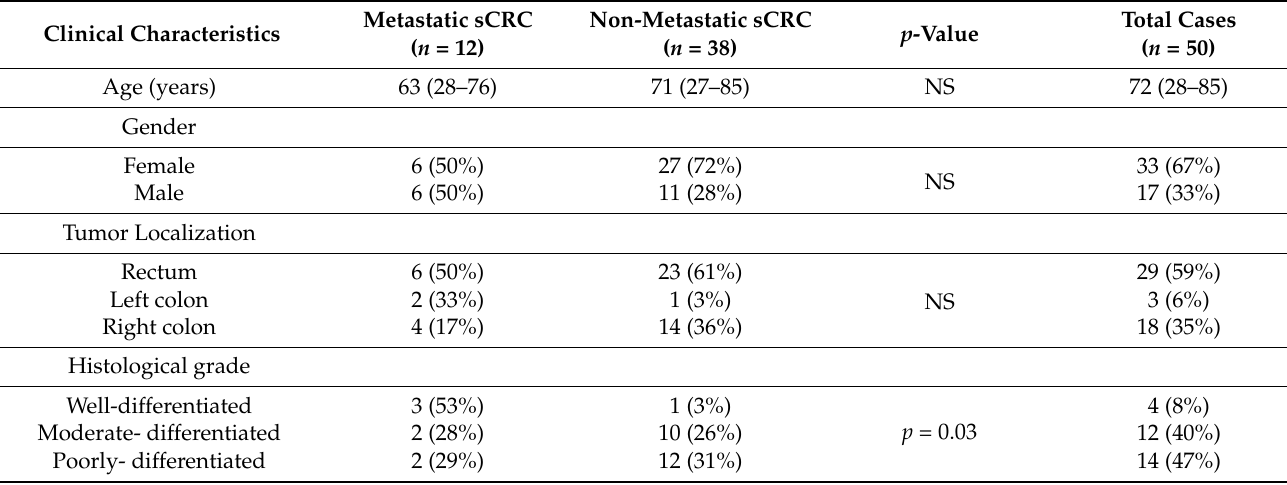
Table 1. Clinical and biological characteristics of non-metastatic ( n = 38) vs. metastatic ( n = 12) sporadic colorectal cancer (sCRC) patients. Clinical